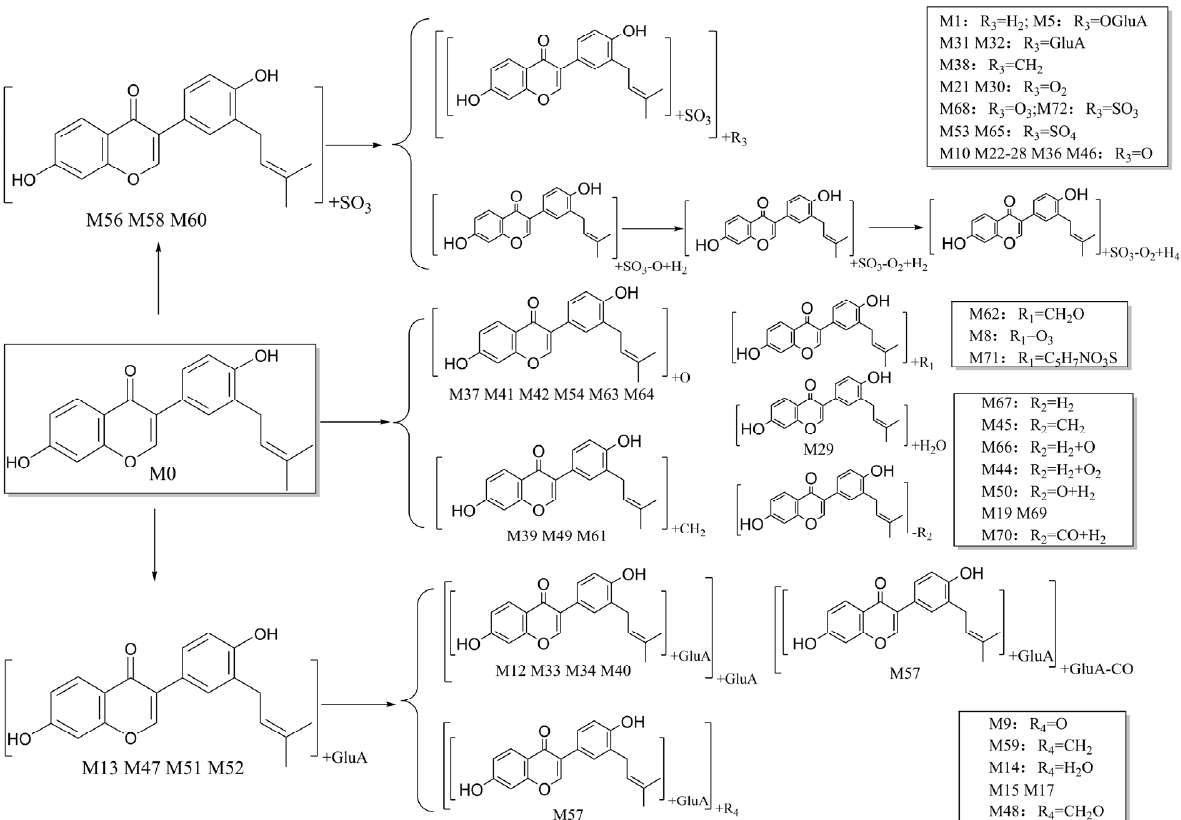
Figure 6. The proposed neobavaisoflavone metabolic pathways in vivo and in vitro.